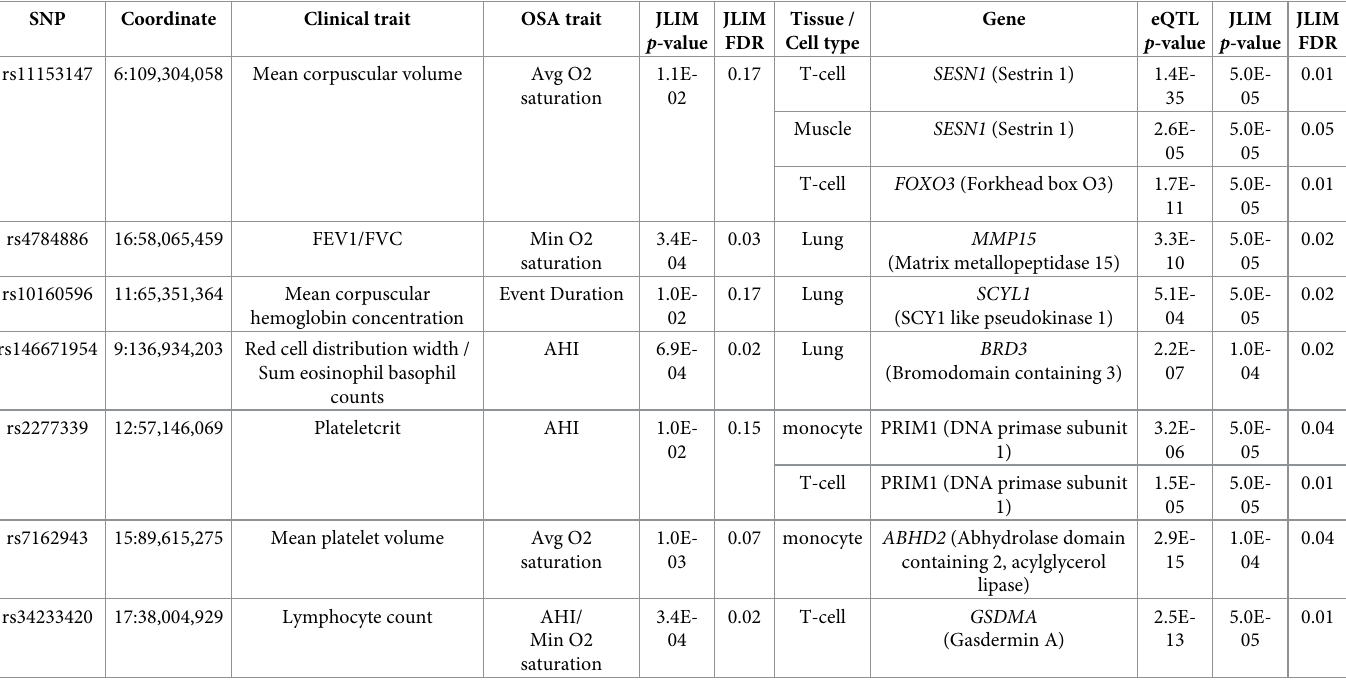
Table 2. Candidate causal